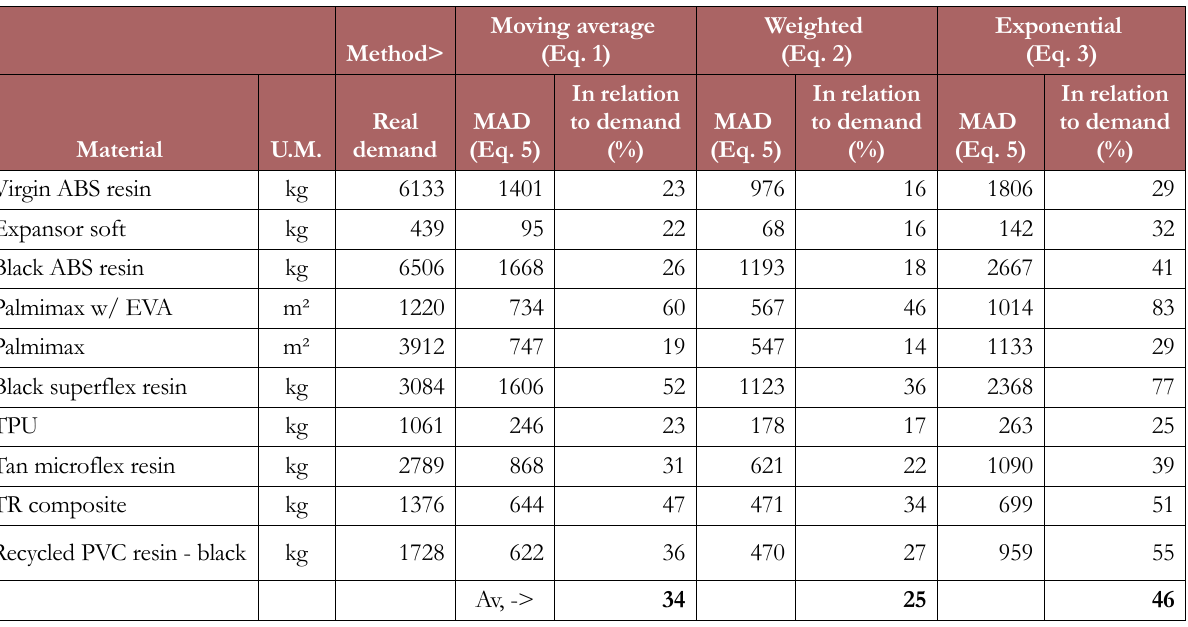
Table 9. Comparison of the methods of demand